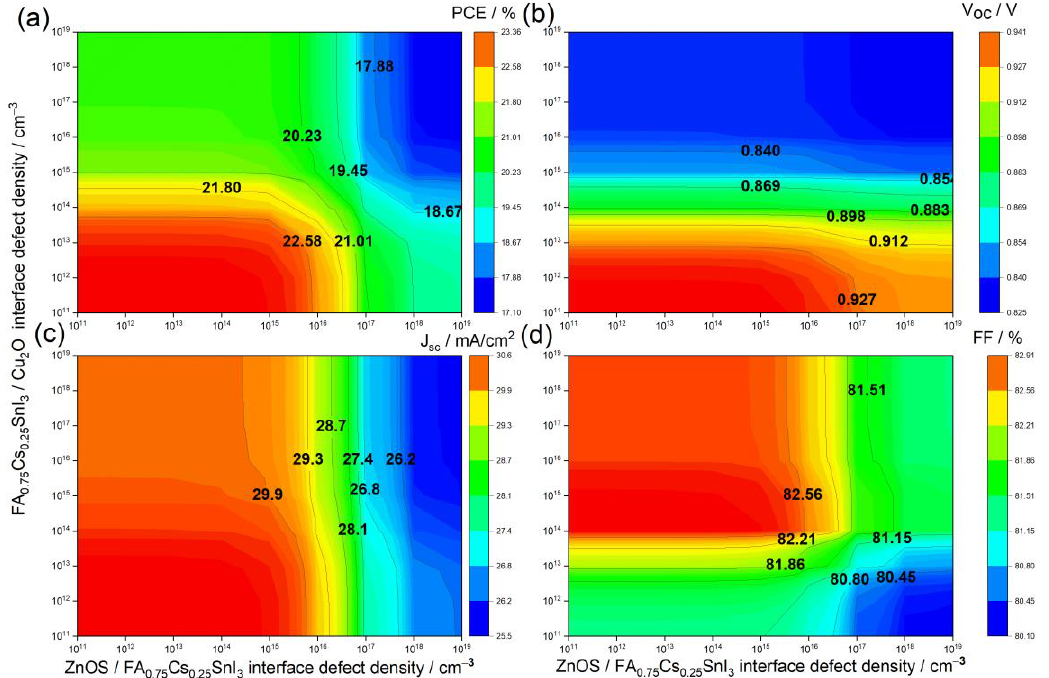
Figure 8. Solar Cell characteristics as function of interface defect densities. ( a ) PCE, ( b ) V oc , ( c ) J sc , and ( d ) FF.